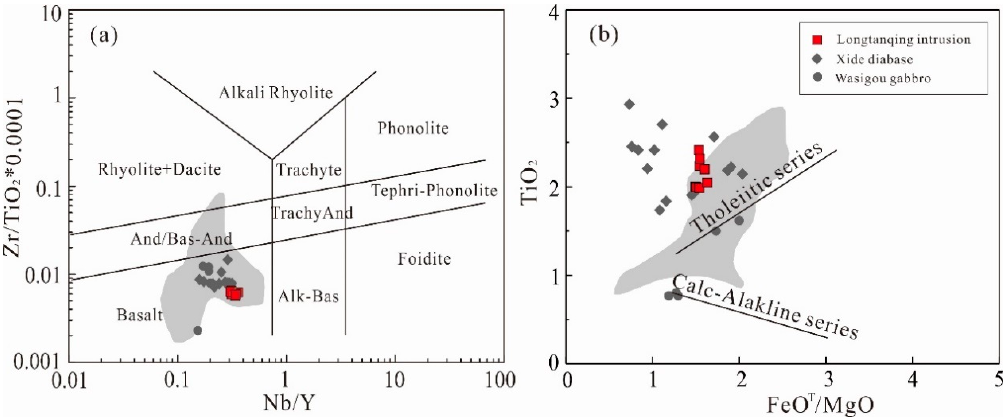
Figure 7. Rock classification diagrams for the samples. ( a ) Nb/Y–Zr/TiO 2 *0.0001 diagram distinguishing subalkaline and alkaline rocks [81]; ( b ) FeO T /MgO–TiO 2 diagram distinguishing tholeiitic and calc-alkaline series [82]. Data for Xide diabase dykes and Wasigou gabbros of western YZB are from [42] and [22], respectively. The shaded areas outline the ranges of compositions for basic-ultrabasic rocks from the Hannan Massif of northwestern YZB with data source from [45].